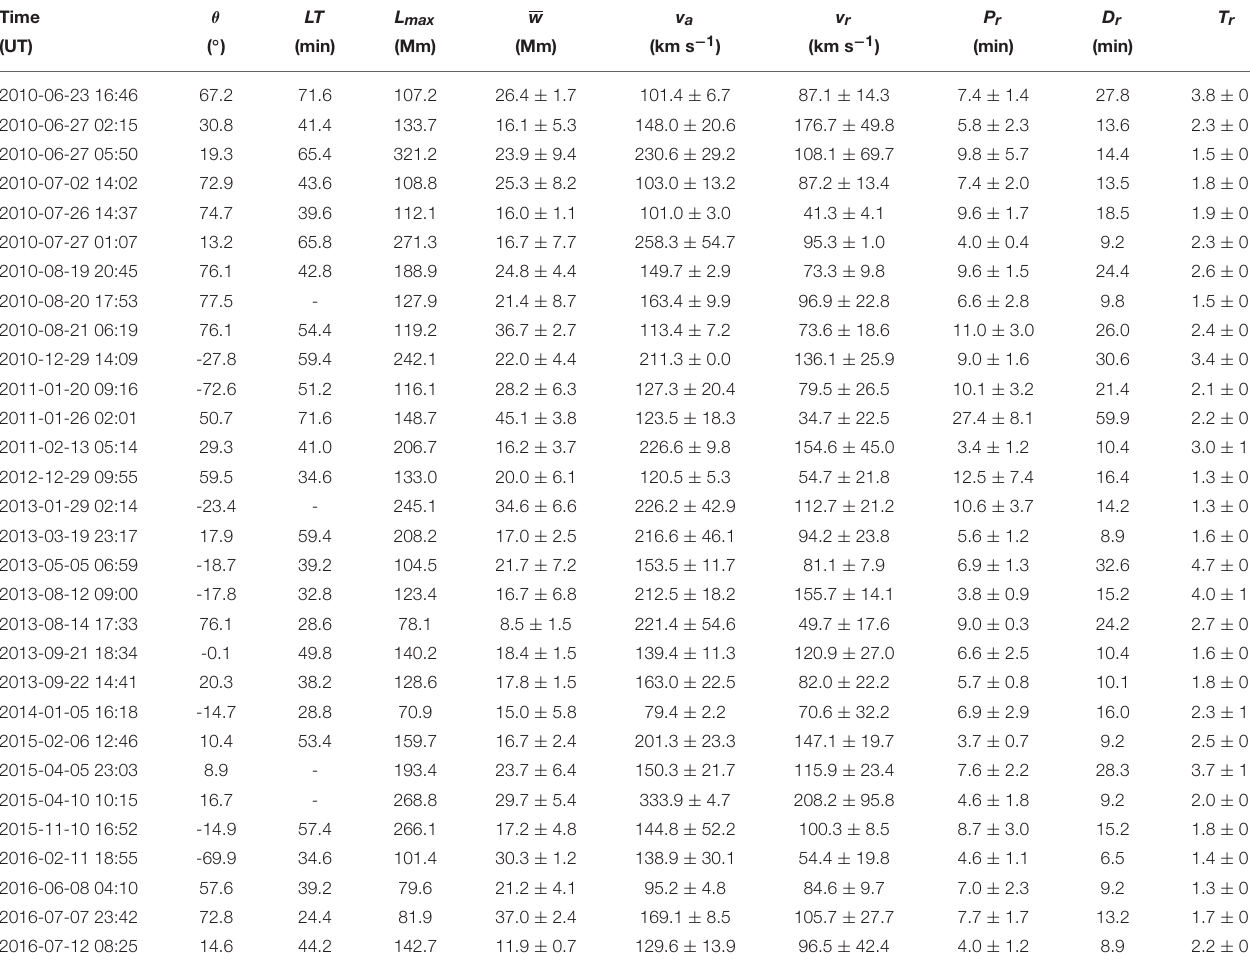
TABLE 1 | Parameters of 30 rotational solar coronal jets observed between 2010 and 2016. Time